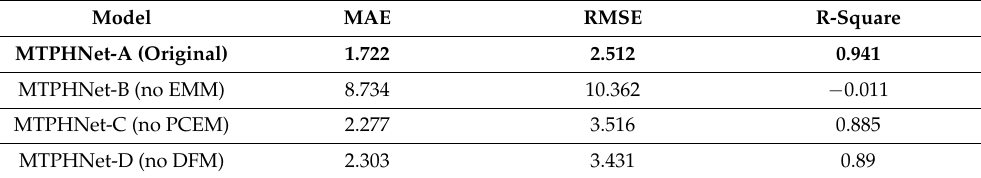
Table 5. Quantitative evaluation metrics of MTPHNet and its variants. All models follow the same procedure and training environment as described in Section 4.1 and are evaluated on the same test set. The best results are shown in